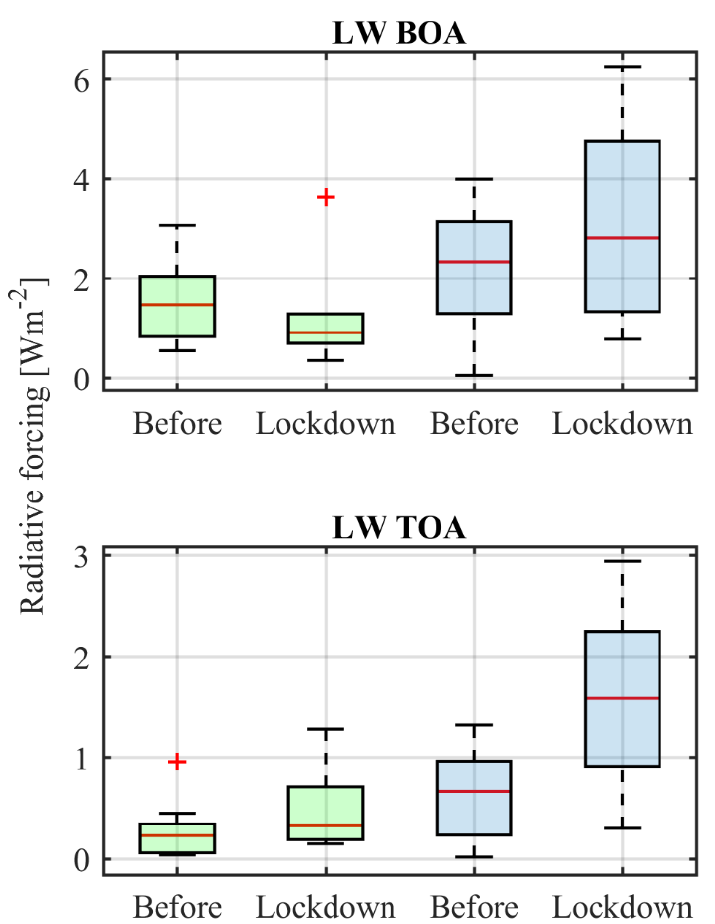
Figure 6. Boxplot of the aerosol radiative forcing in the LW spectral range estimated at the BOA (upper figure) and at the TOA (lower figure) for the morning (green boxes) and afternoon (blue boxes) before and during lockdown cases. Red lines inside the boxes stand for the median value in each scenario, the lower and upper limits of each box represent the 25th and 75th percentile respectively and black horizontal lines extend to the most extreme radiative forcing estimates not considered outliers. Red crosses represent the radiative forcing estimates considered as outliers.